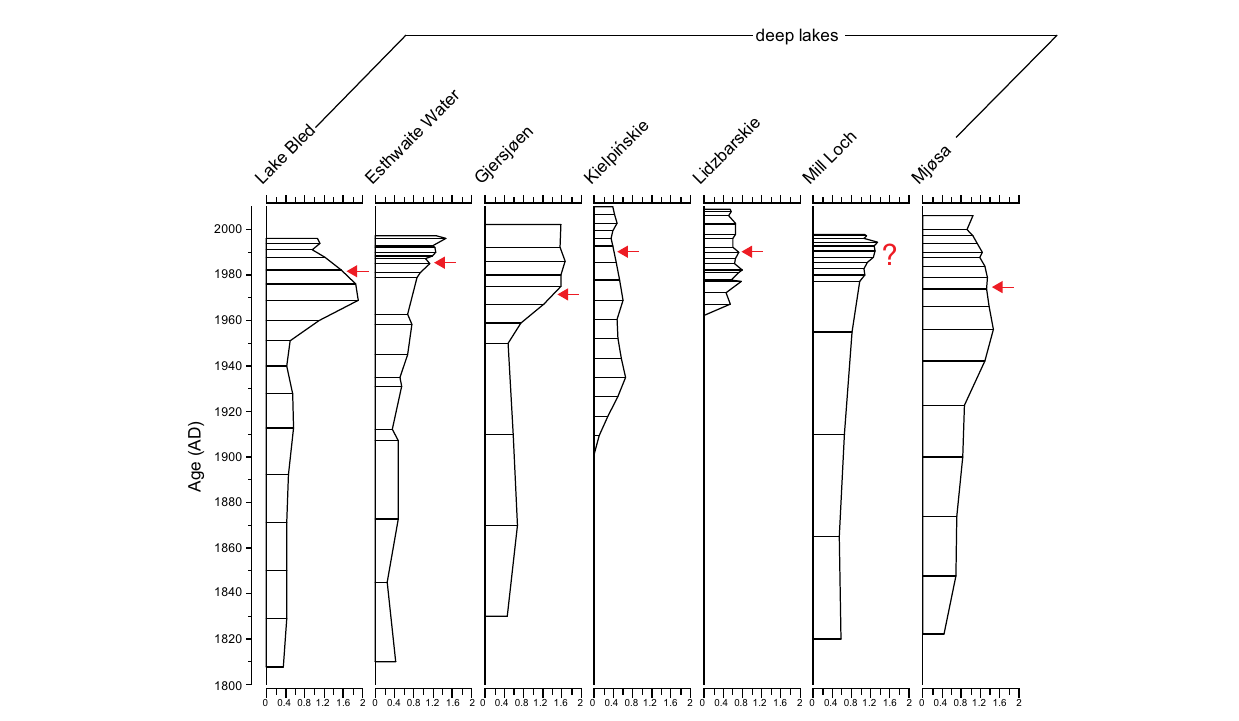
FIGURE 1 | Dissimilarity scores for the 12 study sites. The degree of floristic change in the diatom assemblages between the bottom sample and every other sample in the core; timing of first nutrient reduction is shown by the arrow.